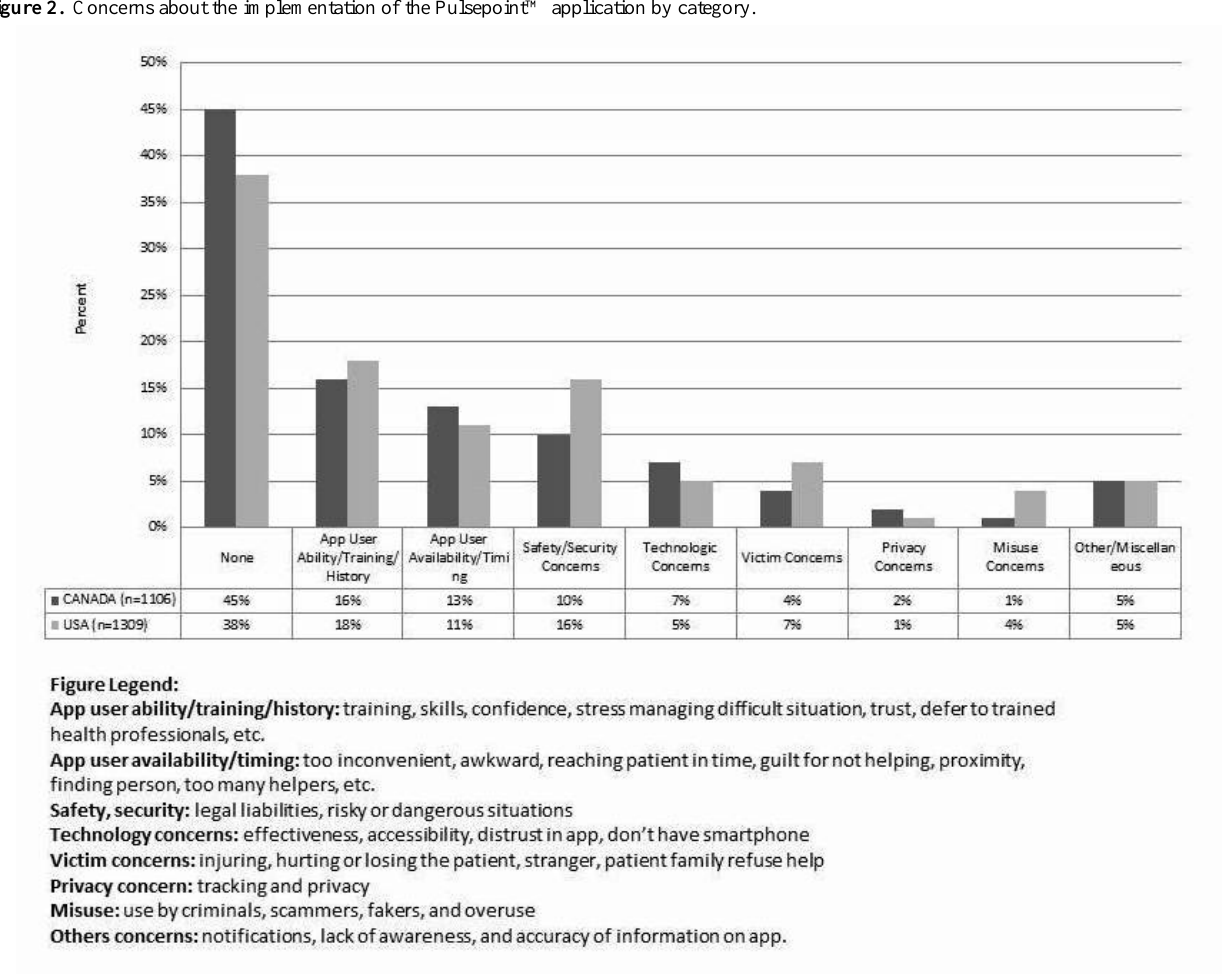
Figure 2. Concerns about the implementation of the Pulsepoint™ application by